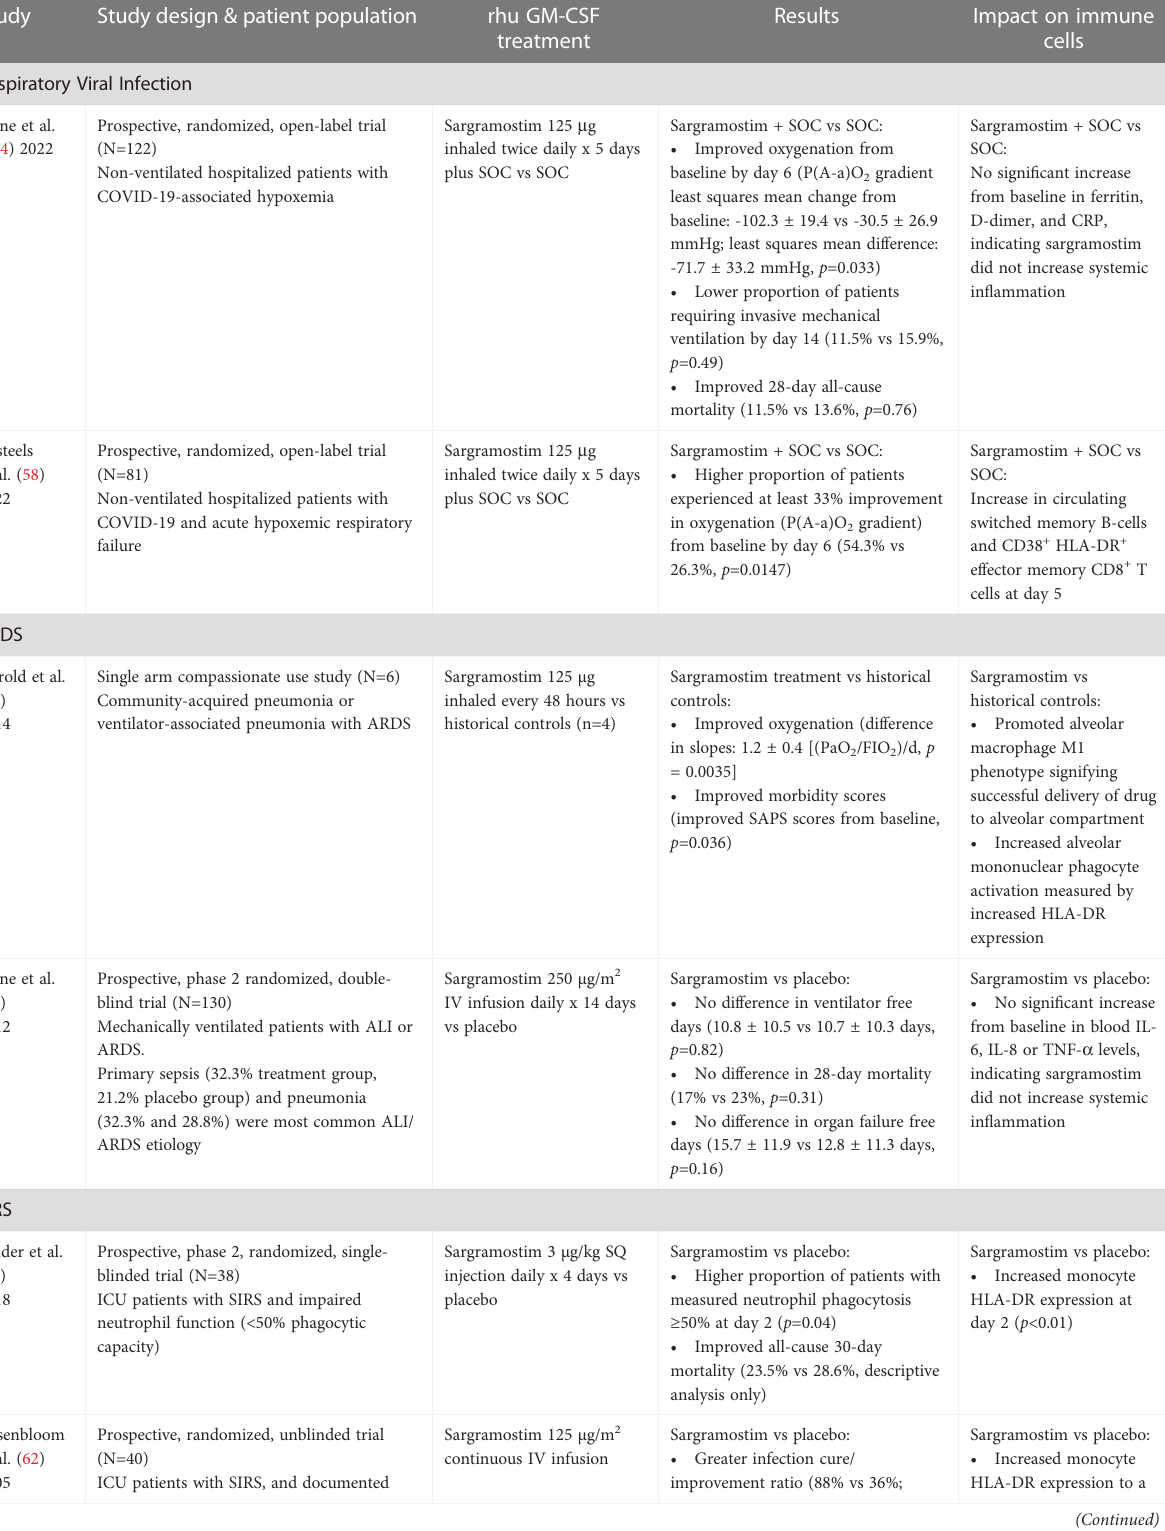
TABLE 3 Use of rhu GM-CSF in respiratory viral infection, ARDS, SIRS, sepsis-induced immunoparalysis, and immune compromise.